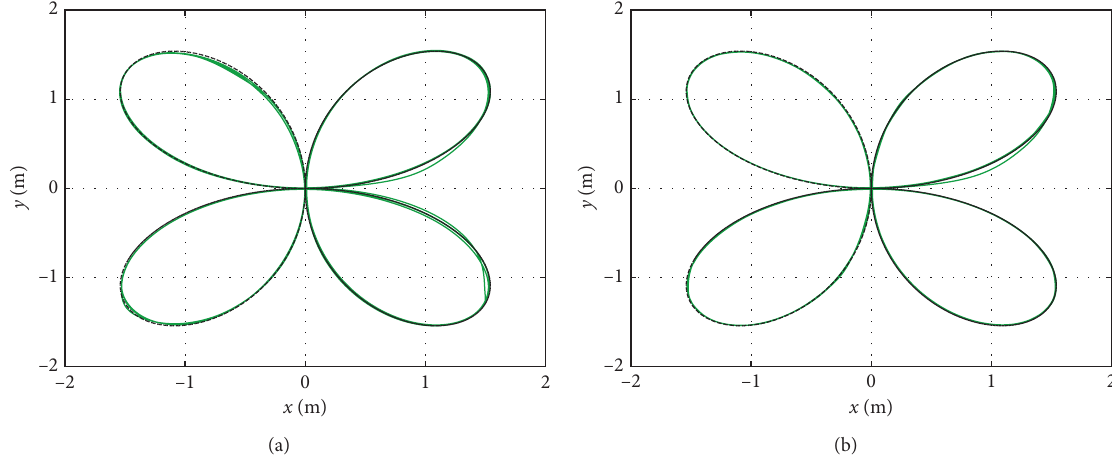
Figure 9: X - Y path followed by the quadrotor vehicle. (a) Path following case 1. (b) Path following case 2.